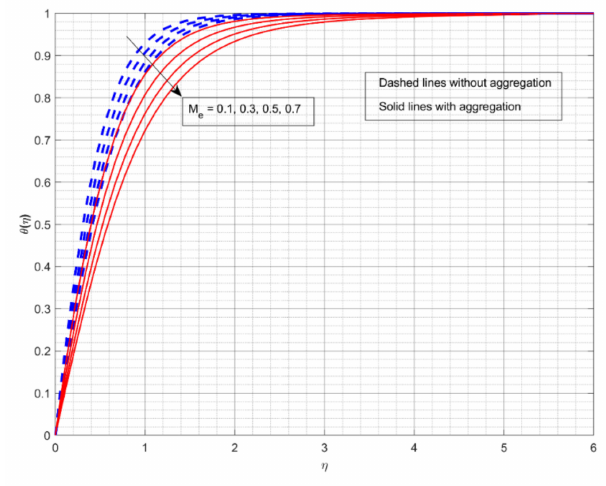
Figure 6. The impact of melting parameteron the thermal profile θ ( η ) .